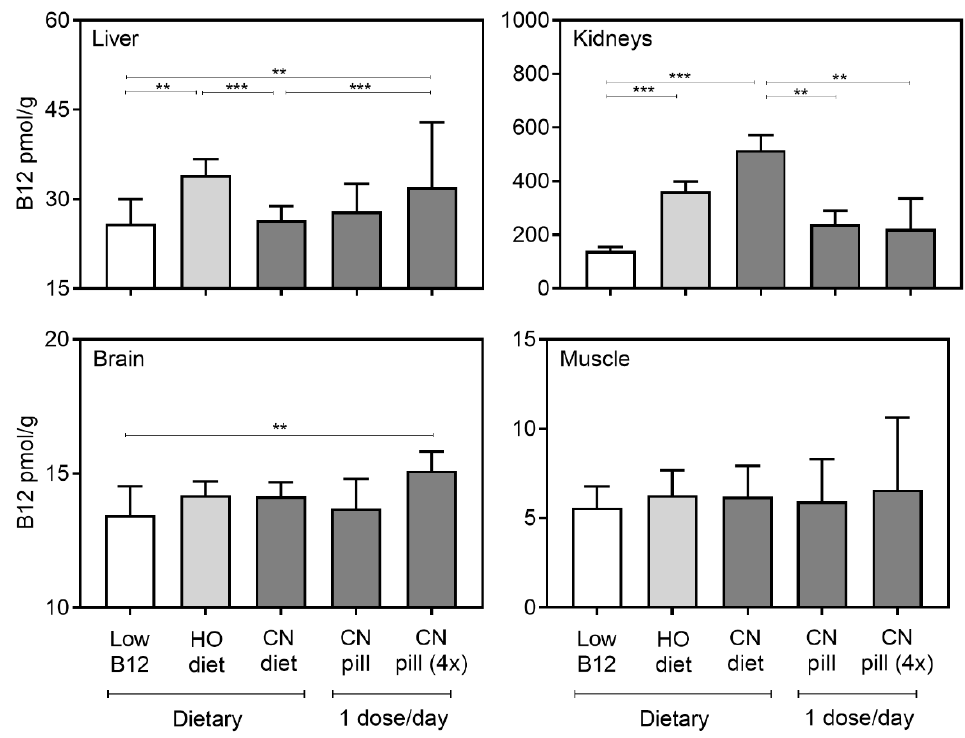
Figure 4. B12 tissue distribution per gram tissues. Liver, kidneys, brain, and muscle tissues were harvested and measured for content of B12. The results are given as pmol/g wet tissue (median with interquartile range). The one-way analysis of variance (ANOVA) with Tukey’s post hoc corrections for multiple comparisons (liver, brain, muscle; normalized data) or the Kruskal-Wallis test with Dunn’s corrections (kidney; not normalized data) was used to compare groups. Asterisks indicate the level of statistical significance ( p < 0.0005 (***), p < 0.005 (**), and p < 0.05 (*)).